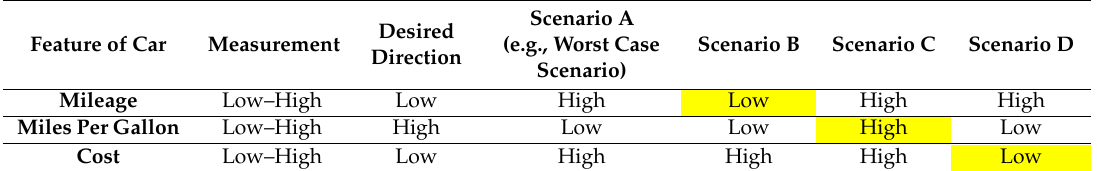
Table 1. Description of attributes.